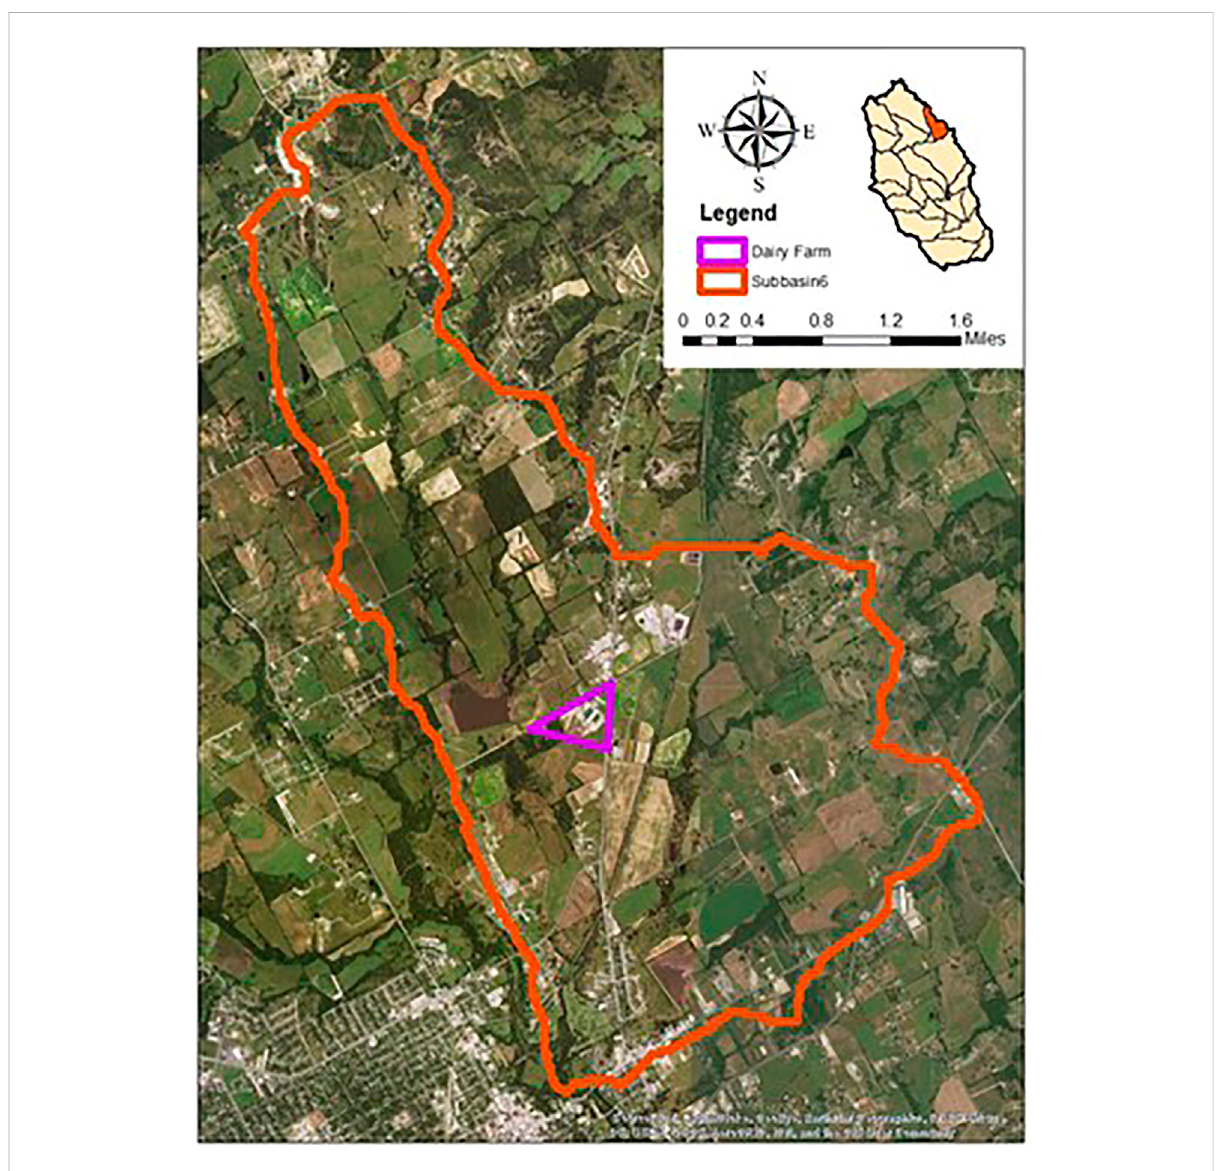
FIGURE 4 Location and satellite view of Subbasin 6, used in SWAT mode: the watershed was created by SWAT based on topography. It lies north of Stephenville and drains into the North Bosque